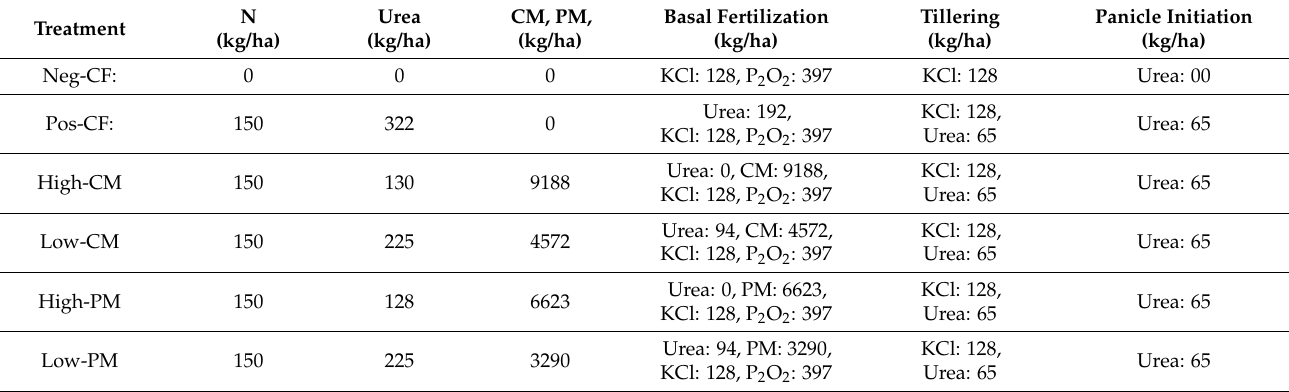
Table 2. Nutrient content and quantity of nutrients supplied to each plot and fertilization